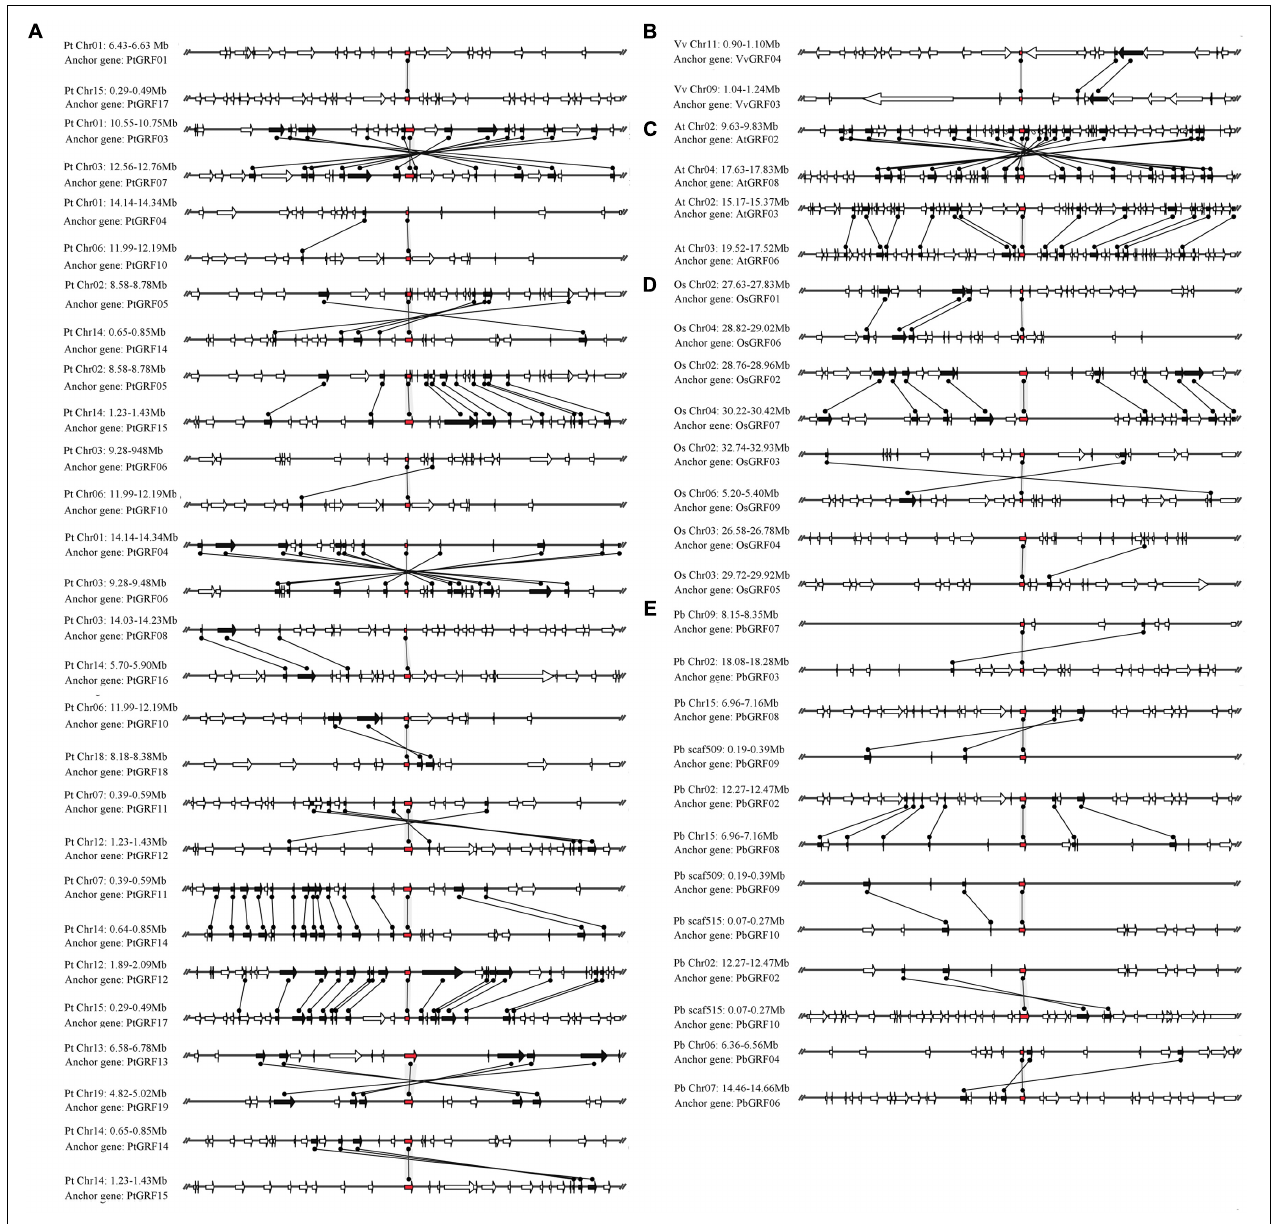
FIGURE 6 | Microsynteny maps of GRF genes in Populus (A), grape (B) , Arabidopsis (C), rice (D) and pear (E) . The relative positions of all flanking protein-coding genes were defined by the anchored GRF genes, highlighted in red. Gray horizontal lines indicate the chromosome segments. Transcriptional orientations are represented by arrows. A gray line connects the conserved gene pairs among the